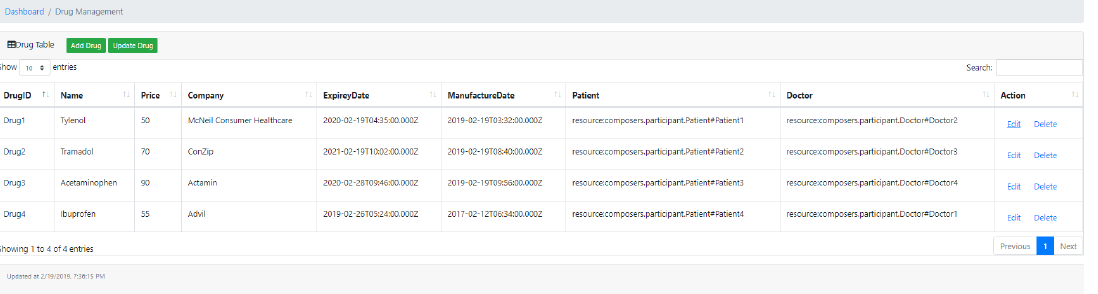
Figure 18. Drug management